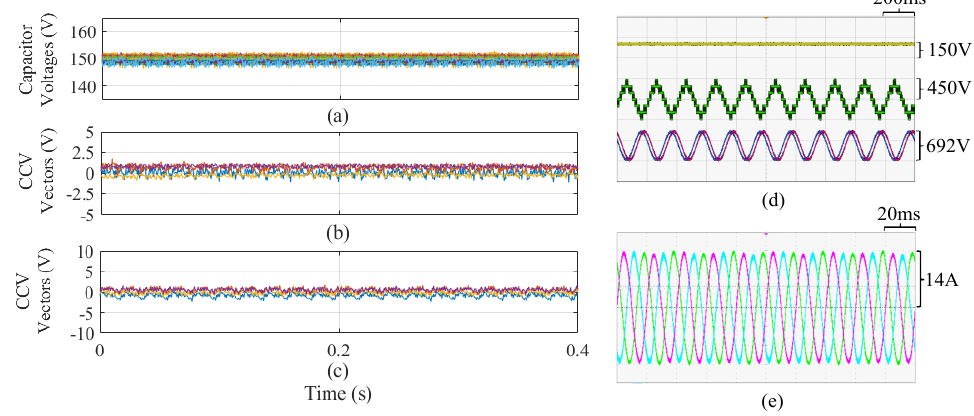
Figure 16. Experimental results considering closed-loop CCV regulation in EFM. ( a ) Twenty-seven floating capacitor voltages. ( b ) Four CCVs in Σ∆ double– αβγ . ( c ) Remaining CCVs in Σ∆ double– αβγ . ( d ) Oscilloscope voltage waveforms. ( e ) Oscilloscope current waveforms. Adapted from